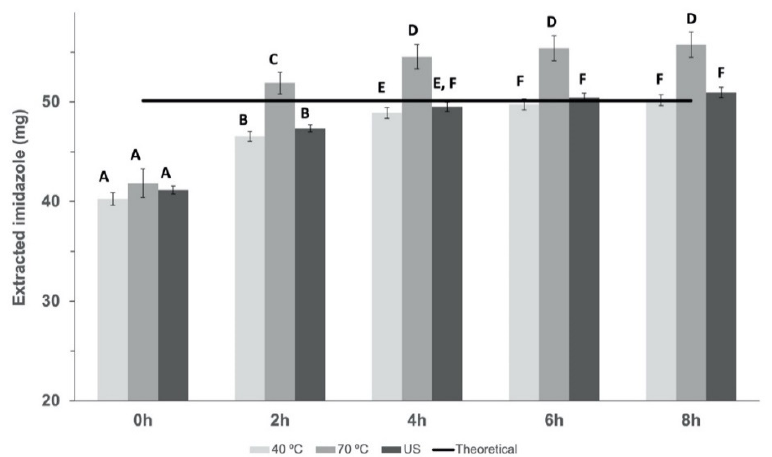
Figure 10. Results of the amount of imidazole extracted across time at 40 ◦ C and 70 ◦ C under constant stirring and ultrasonic extraction. Mean ± SD of three replicates is shown and compared against the theoretical imidazole in the samples. Different letters show significant differences ( p ≤ 0.05) between samples.